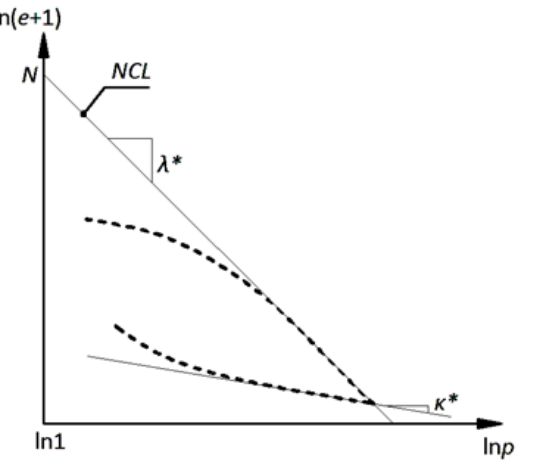
Figure 1. Parameters λ ∗ , κ ∗ and N in the ln p × ln( e + 1) space